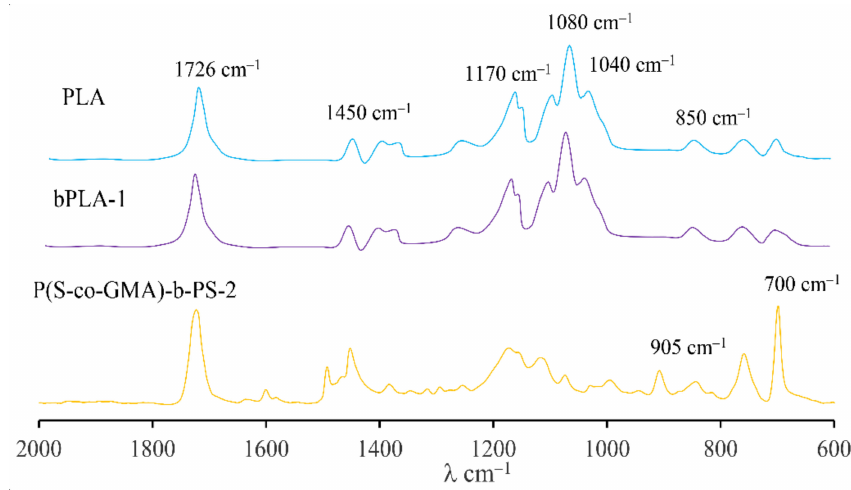
Figure 6. FTIR spectra of PLA, P(S-co-GMA)-b-PS and bPLA.